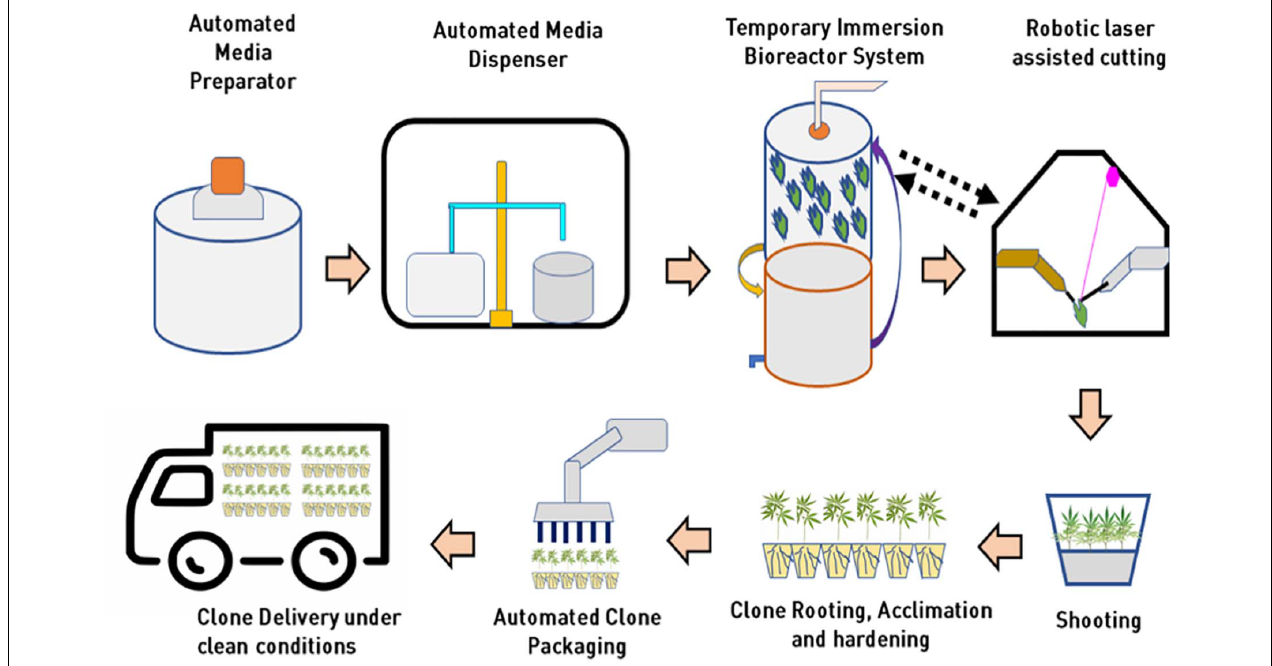
FIGURE 8 | Integration of automation and bioreactor technologies for mass propagation in cannabis for low cost clonal multiplication at in vitro